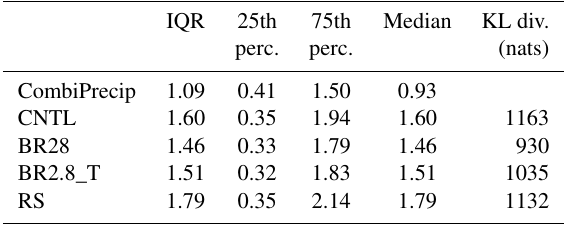
Table 3. Interquartile range (IQR) between the 25th and 75th per- centiles and median in millimeters per hour (hereafter mmh − 1 ) for CombiPrecip and the sensitivity simulations and the Kullback– Leibler divergences between CombiPrecip and the sensitivity simu- lation precipitation